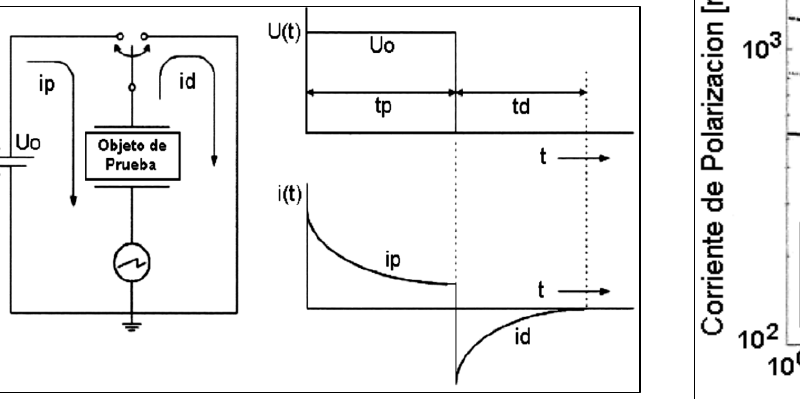
Figura 9: Corrientes de polarización y depolarización. Fuente: Autores, (2017).